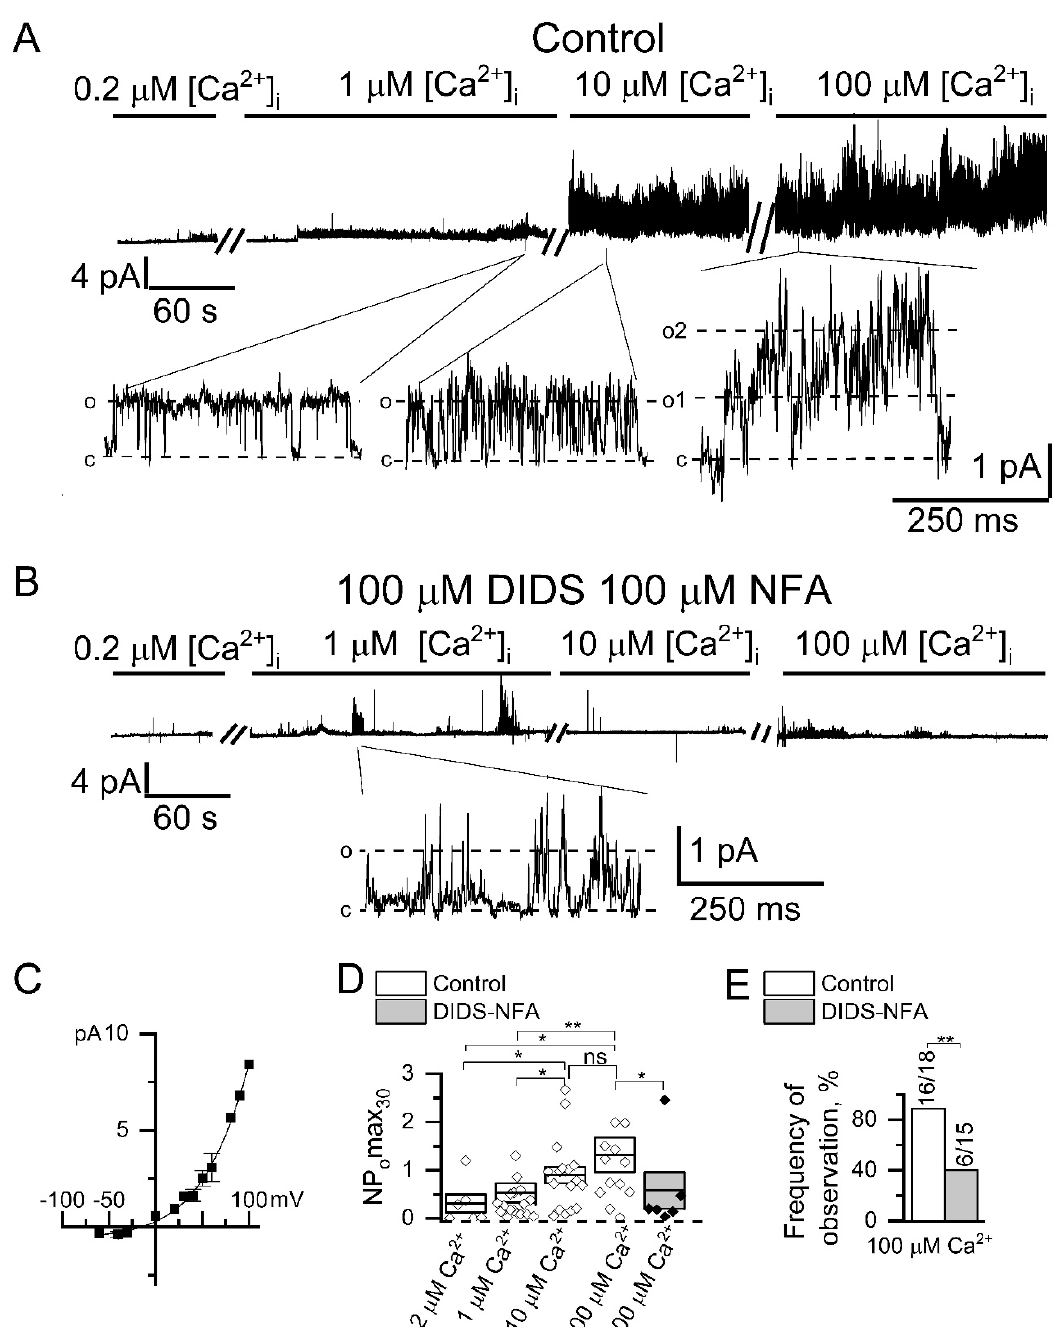
Figure 3. Endogenous CaCCs activated by direct Ca 2+ application in HEK293 cells. ( A ) Representative recordings of channels activated by the increase in intracellular Ca 2+ concentration. Shown are traces at compressed and expanded scale recorded in inside-out configuration at holding potential of +40 mV. ( B ) Representative traces of channels activated by the increase in intracellular Ca 2+ concentration recorded at the same conditions as in panel A but in the presence of 100 µM NFA and 100 µM DIDS in the recording pipette. ( C ) Current–voltage relationship for CaCCs activated by direct 100 µM Ca 2+ application ( n = 3). ( D ) A summary plot of the CaCCs open channel probability in inside-out recordings at holding potential of +40 mV. The data are presented for different cytoplasmic Ca 2+ concentration, and with or without chloride channel blockers NFA (100 µM) and DIDS (100 µM). ( E ) The frequency of CaCC observation in patches is plotted as a proportion of positive experiments to the number of experiments in the series. The data are presented for experiments with bath application of 100 µM Ca 2+ with or without 100 µM NFA and 100 µM DIDS in the pipette. Data are shown as means ± S.E. Differences are considered significant when p values are <0.05 (*), and <0.01 (**).